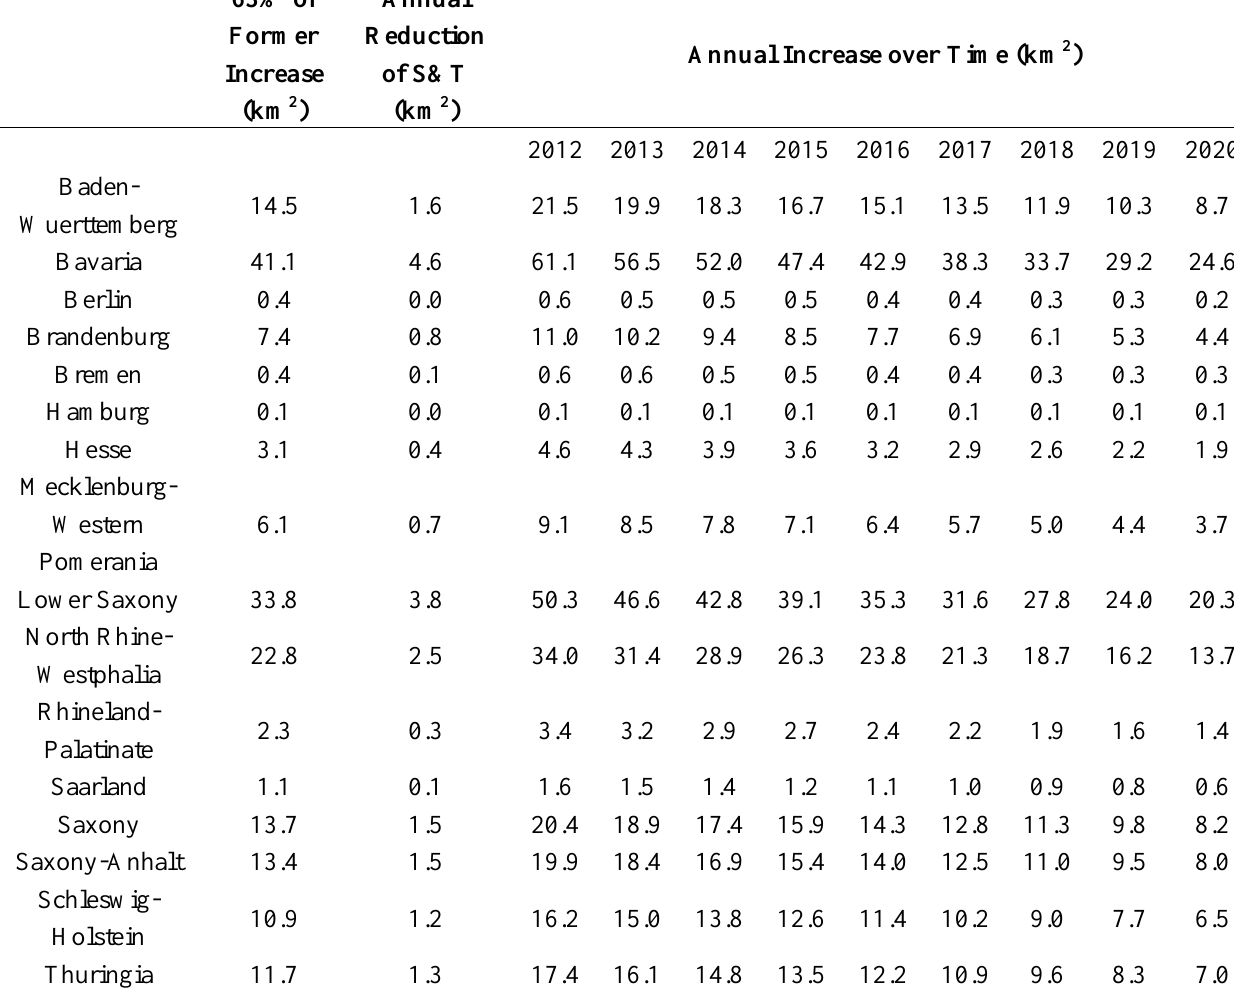
Table 2. Increase of S&T area according to Scenario